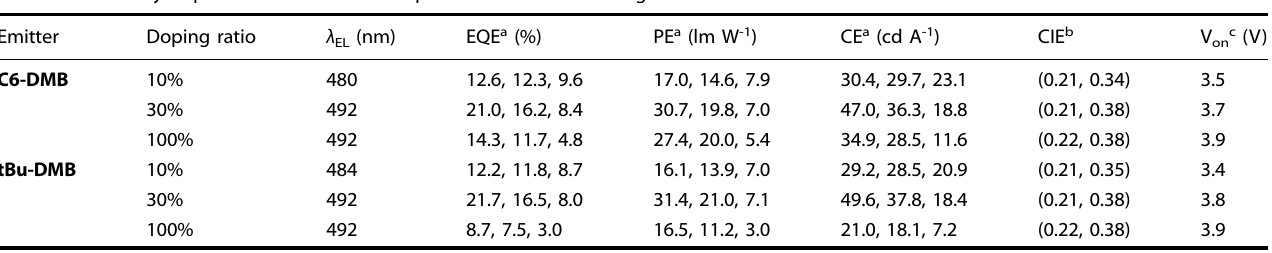
Table 2. Summary of performance for solution-processed devices utilizing C6-DMB and tBu-DMB .